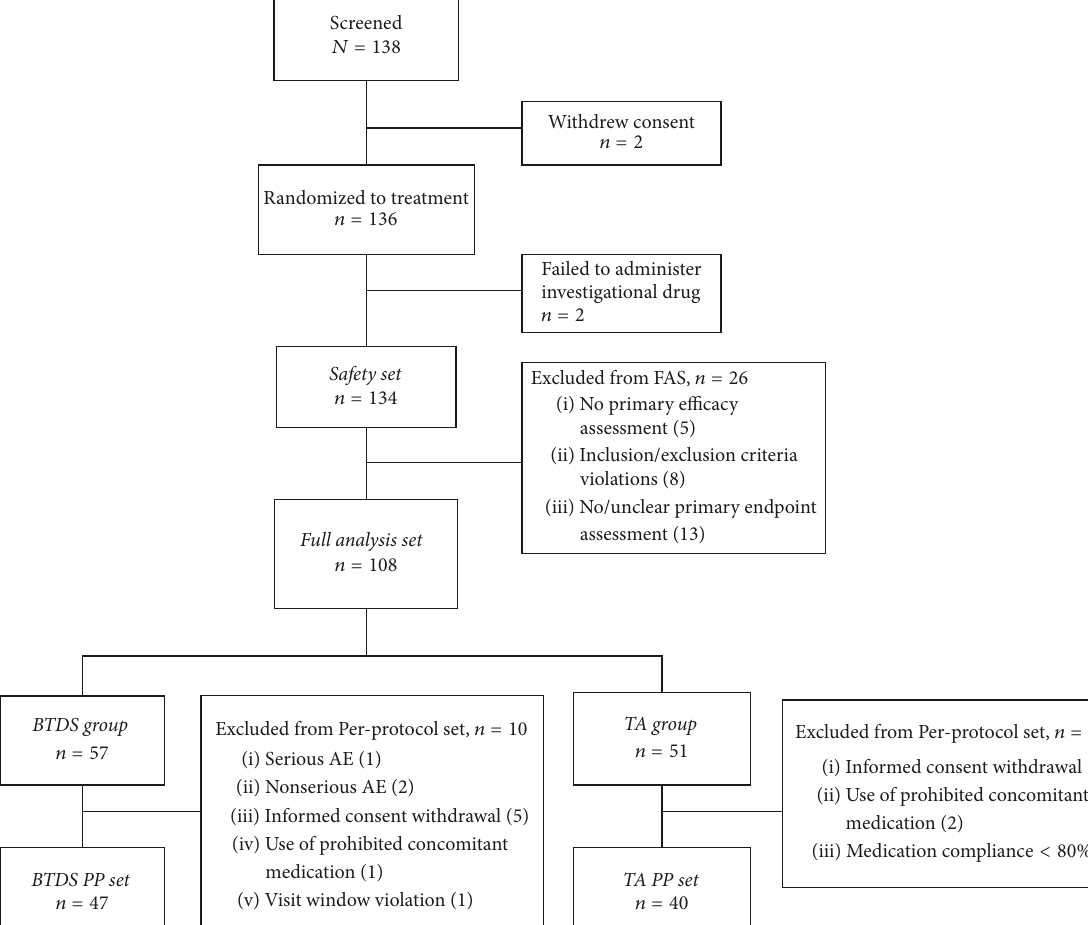
Figure 2: Flow of patients through the trial . FAS: full analysis set; BTDS: buprenorphine transdermal system (NORSPAN); TA: tramadol/acet-